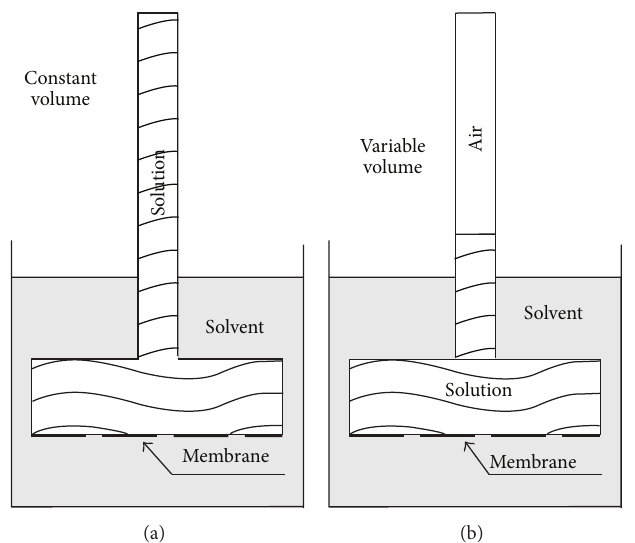
Figure 1: Schematic of the two experimental osmotic regimes: (a) open cell (variable volume); (b) closed cell (constant